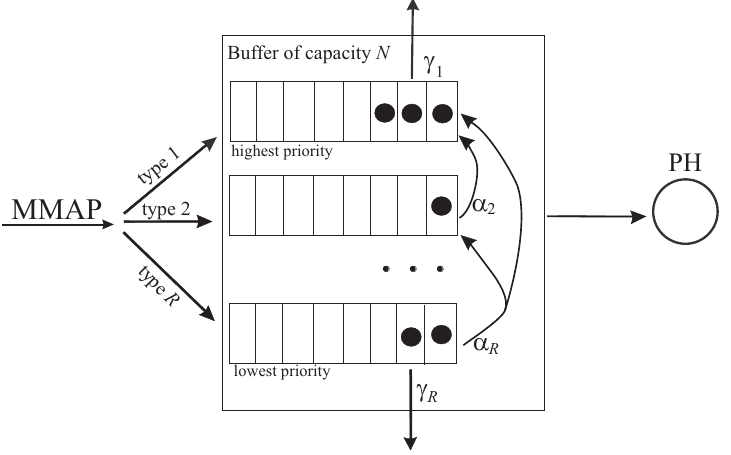
Figure 1. Structure of the